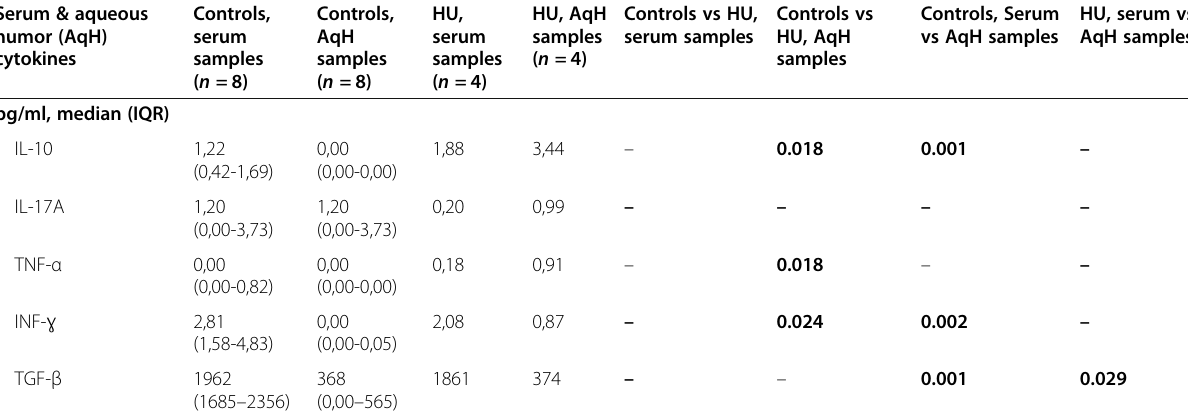
Table 2 Comparison of cytokine levels in HU patients and controls Serum & aqueous humor